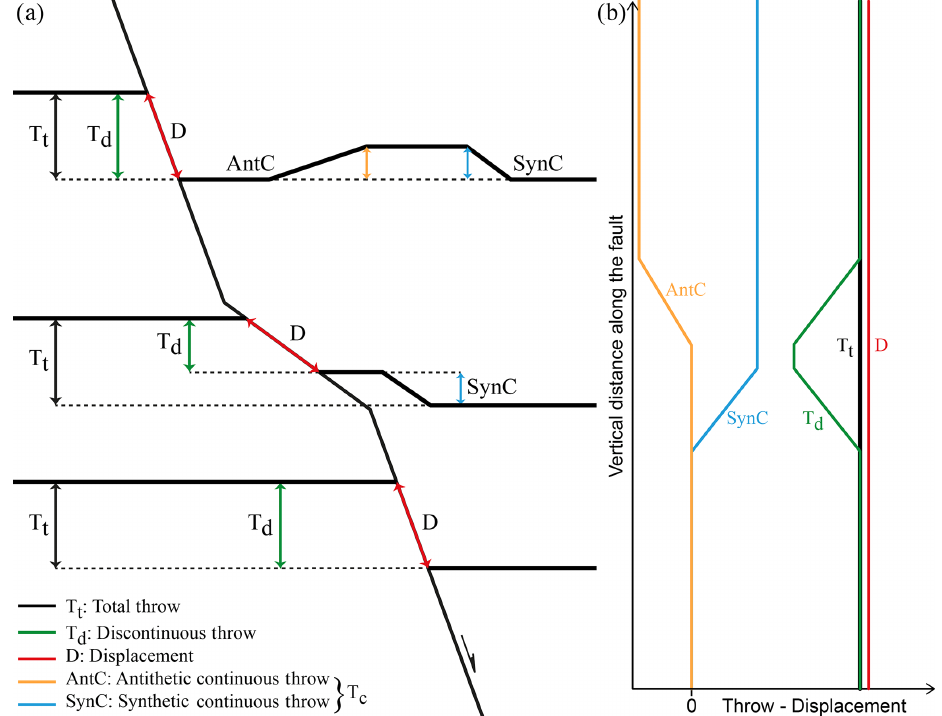
Figure 2. (a) Schematic diagram of a fault that comprises three fault segments forming two sharp fault bends, a convex (bottom) and a concave (top). The total throw ( T t ) is partitioned into the discontinuous throw ( T d ) and the continuous throw ( T c ); the later comprises the antithetic continuous throw (AntC) and the synthetic continuous throw (SynC). (b) Throw-displacement profiles along the nonplanar fault in (a) showing the complementary variations in the discontinuous and continuous throws given that the total throw and the displacement are constant and unaffected by the fault